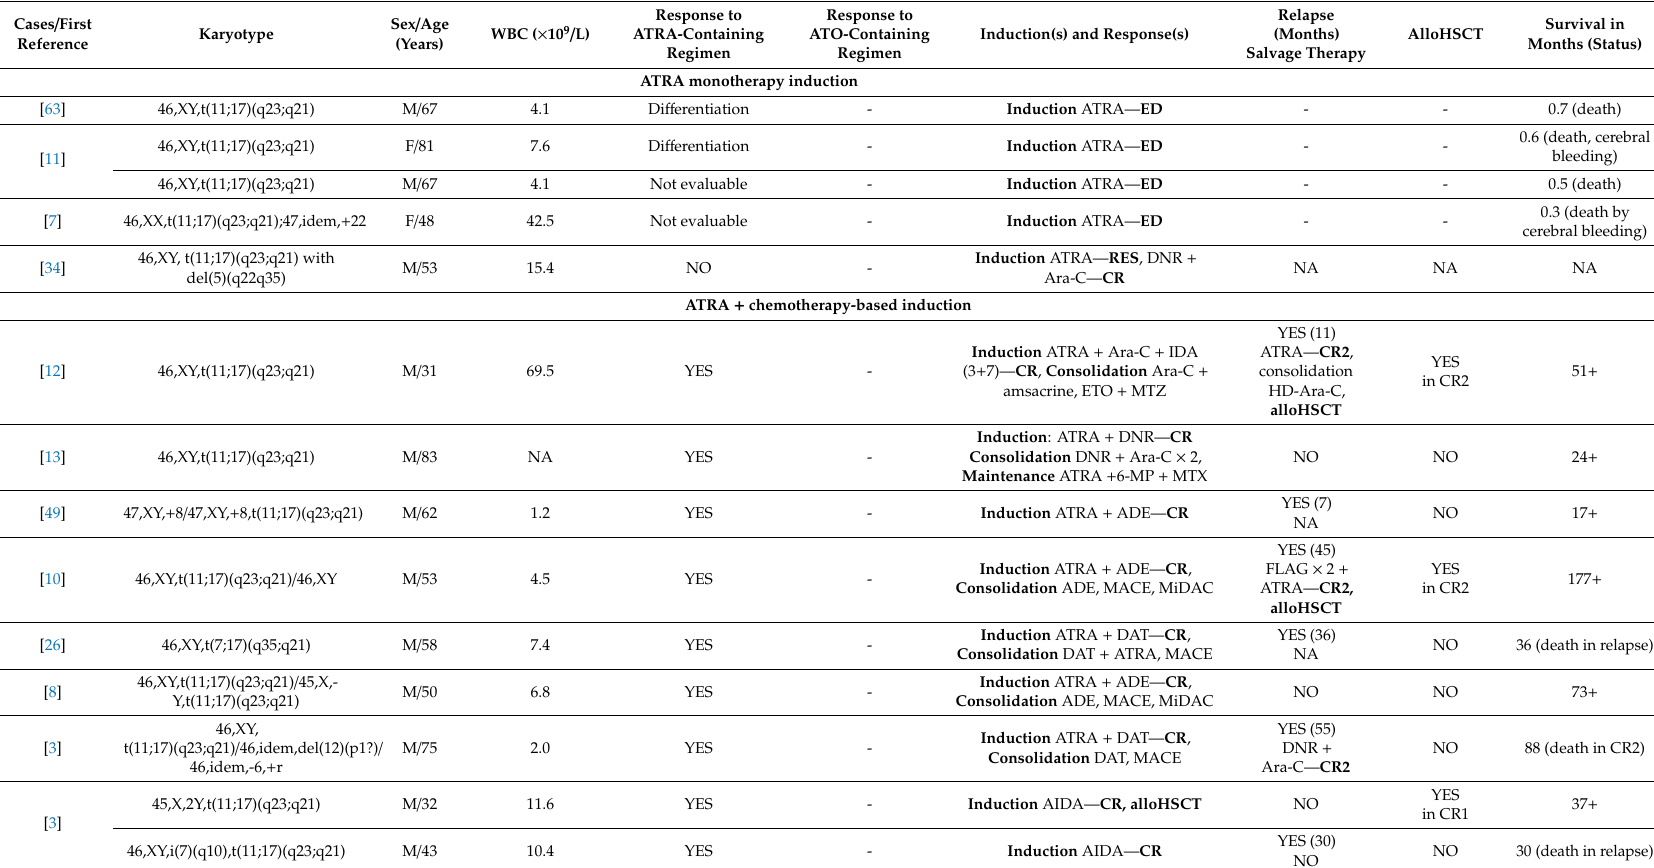
Table 2. Characteristics and clinical outcomes in patients reported with